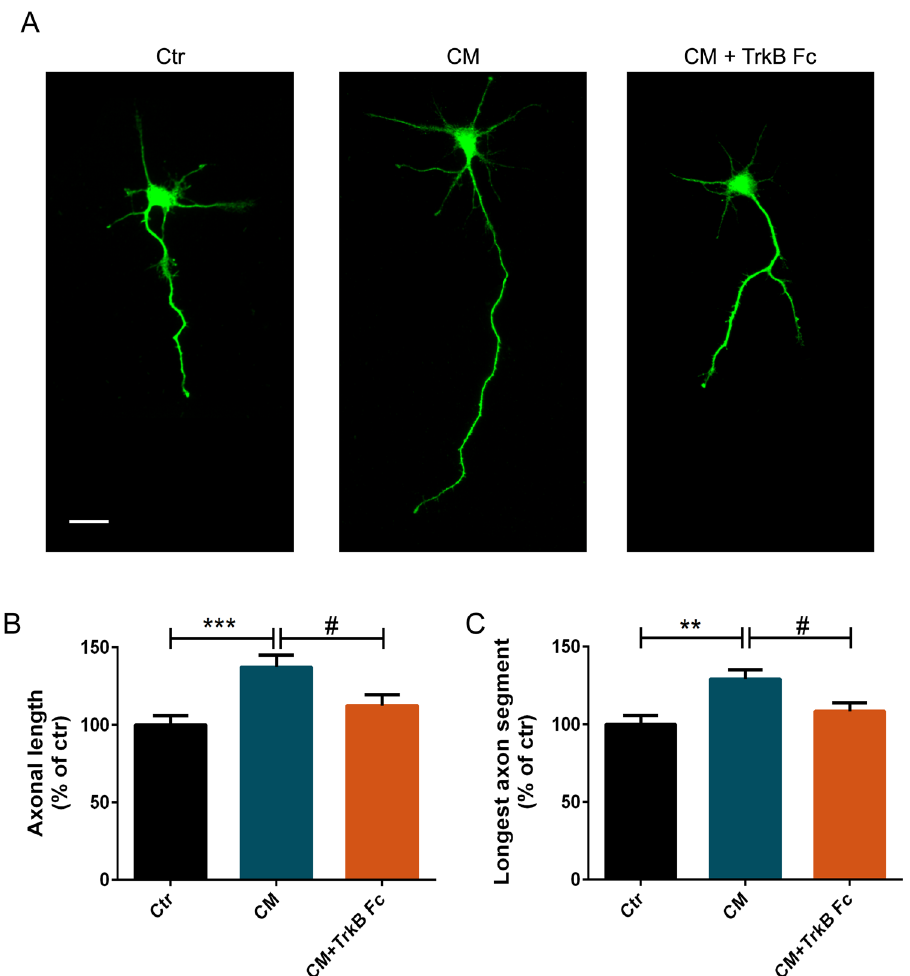
Figure 5. BDNF is the main component of CM-induced axonal outgrowth in cortical neurons. ( A ) Depletion of BDNF prevented CM-induced axon outgrowth. Cortical neurons were globally stimulated with CM for 14 h at DIV5-6. Axonal outgrowth was assessed by immunocytochemistry using an antibody against Tau. Images were taken from random neurons using an AxioObserver Z1 fluorescent microscope with a PlanApochromat 20 × objective. Global application of CM induced axon outgrowth, as previously described. However, when BDNF is depleted from the conditioned media using a specific antibody this effect is abolished. In the absence of BDNF, the axonal length and the range of the longest axons are similar to control values, indicating that BDNF is one the major molecules involved in the CM-induced axonal outgrowth effect. ( B , C ) Quantification of axonal length ( B ) and axonal longest segment ( C ). Axonal length and longest axonal segments measuring was performed with Image J 1.45e software. Results show that CM stimulation increases the axonal network, and in addition neurons stimulated with CM have the longest axonal segments. However, when BDNF is depleted, with the addition of 1 µ g/mL of TrkB Fc, a molecule that binds specifically to BDNF molecules neutralizing them, there is no increase in axonal length nor in the axonal longest segments. Bars and plots represent the mean ± SEM of approximately 60 neurons randomly selected of 4 independent experiments. ( B ) *** Represents p = 0.0004 by one-way ANOVA analysis of variance using Tukey post test when Ctr is compared to CM; # represents p = 0,0307 by one-way ANOVA analysis of variance using Tukey post test when CM is compared to CM + TrkB Fc. ( C ) ** Represents p = 0,0014 by one-way ANOVA analysis of variance using Tukey post test when Ctr is compared to CM; # represents p = 0.0341 by one-way ANOVA analysis of variance using Tukey post test when CM + TrkB Fc compared to CM. The scale bar is 25 µ